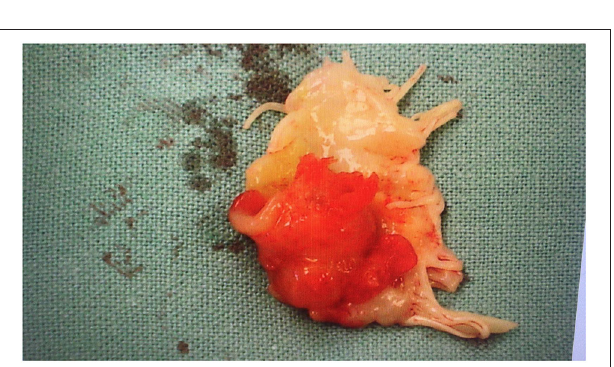
FIGURE 2 | Large vegetation on the atrial face of anterior mitral valve leaflet.